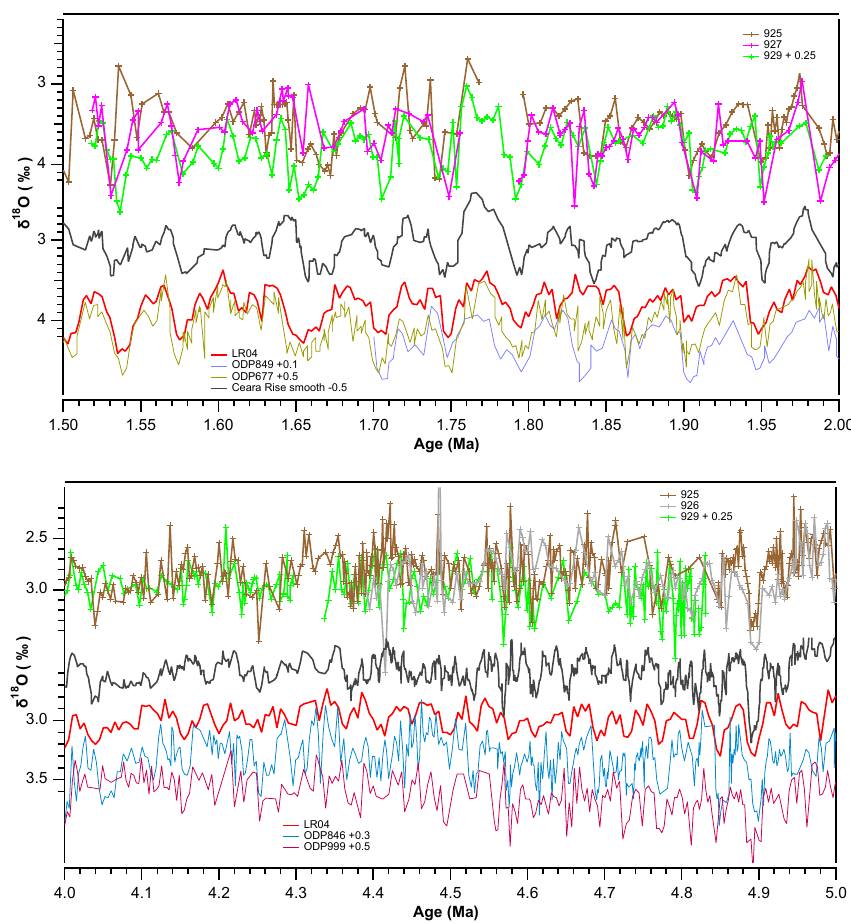
Figure 9. Detail from Fig. 8 comparing individual holes to one another and a smoothed composite to LR04 for the intervals 1.5 to 2.0 and 4.0 to 5.0Ma. For better illustration we plotted the initial alignment target records of the LR04 stack. For the 1.5 to 2.0Ma interval these are the records from ODP sites 677 and 849; for the interval 4.0 to 5.0Ma these are the records from ODP sites 846 and 999. Some records have been shifted as indicated in the figure for better comparison of the data with each other. Note the differences between LR04 and the Ceara Rise average at 1.80–1.85Ma, although the initial alignment targets are more similar to the Ceara Rise smooth. Also note the difference between 4.0 and 4.5Ma. The Site 999 record is from a single hole and the splice of the Site 846 record might be erroneous. The age model for the Ceara Rise is very robust in this interval (see Fig. 10) pointing to potential inconsistencies in the age model construction of the Site 846 and Site 999